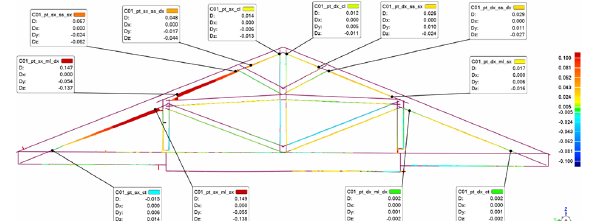
Figure 15: Bidimensional representation of the displacement observed by overlapping the ideal 3D model and the point cloud of a single truss. Annotation for rafters control points Many types of movements or deviations can be highlighted by conveniently choosing these control points along some truss members constituting each truss under investigation. Precisely